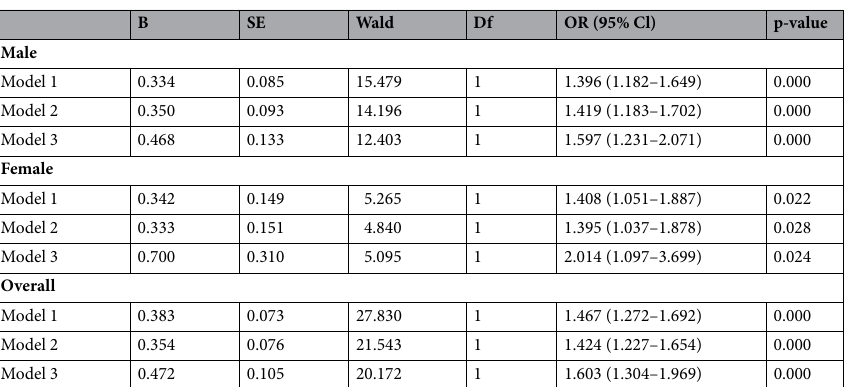
Table 4. Evaluation of the association between XO and T2D. Association between XO levels and T2D was determined by Multinomial logistic regression. The dependent variable was T2D (yes) and the independent variable was XO (U/L). The reference category is control (non-T2D). Model 1: adjusted for age, BMI, SBP and DBP. Model 2: model 1 + SUA. Model 3: model 2 + lipid markers (TG, TC, HDL, LDL), SA, eGFR and smoking status. OR odds ratio, CI confidence interval, SE standard